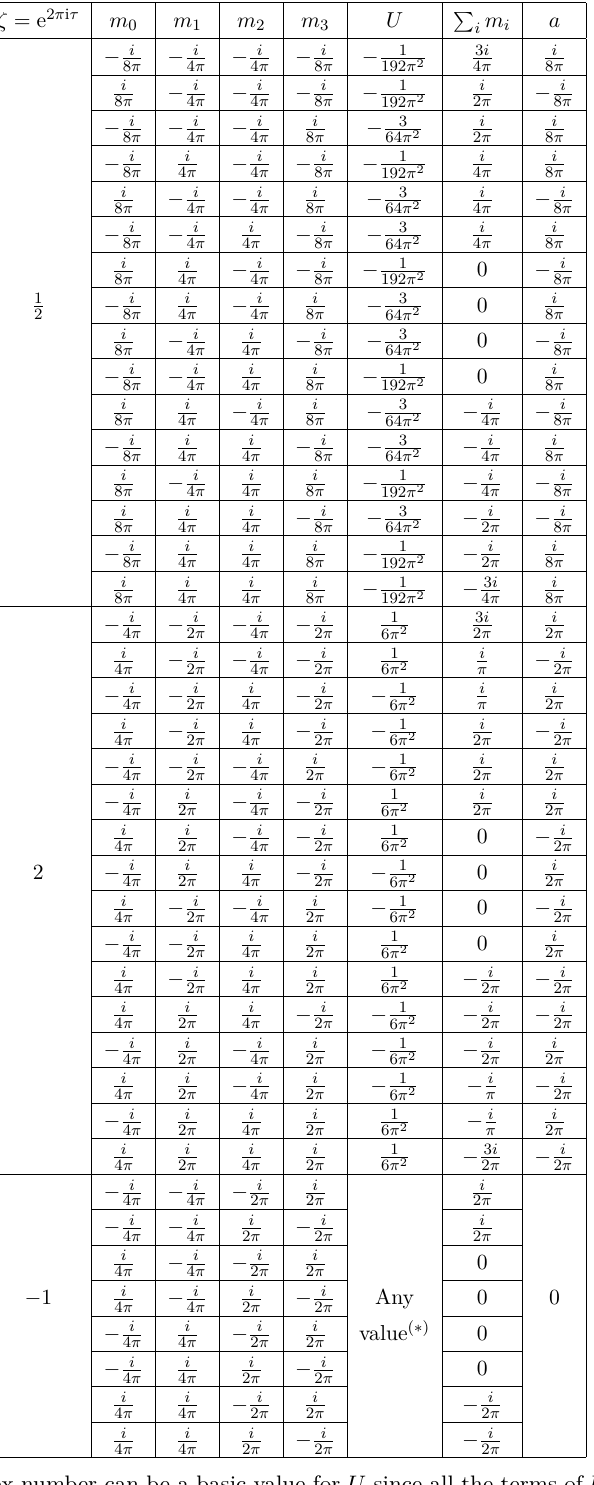
Table 3. The parameters obtained from Γ 0 (4) ∩ Γ(2) . Using (3.21), we can get the values for α i